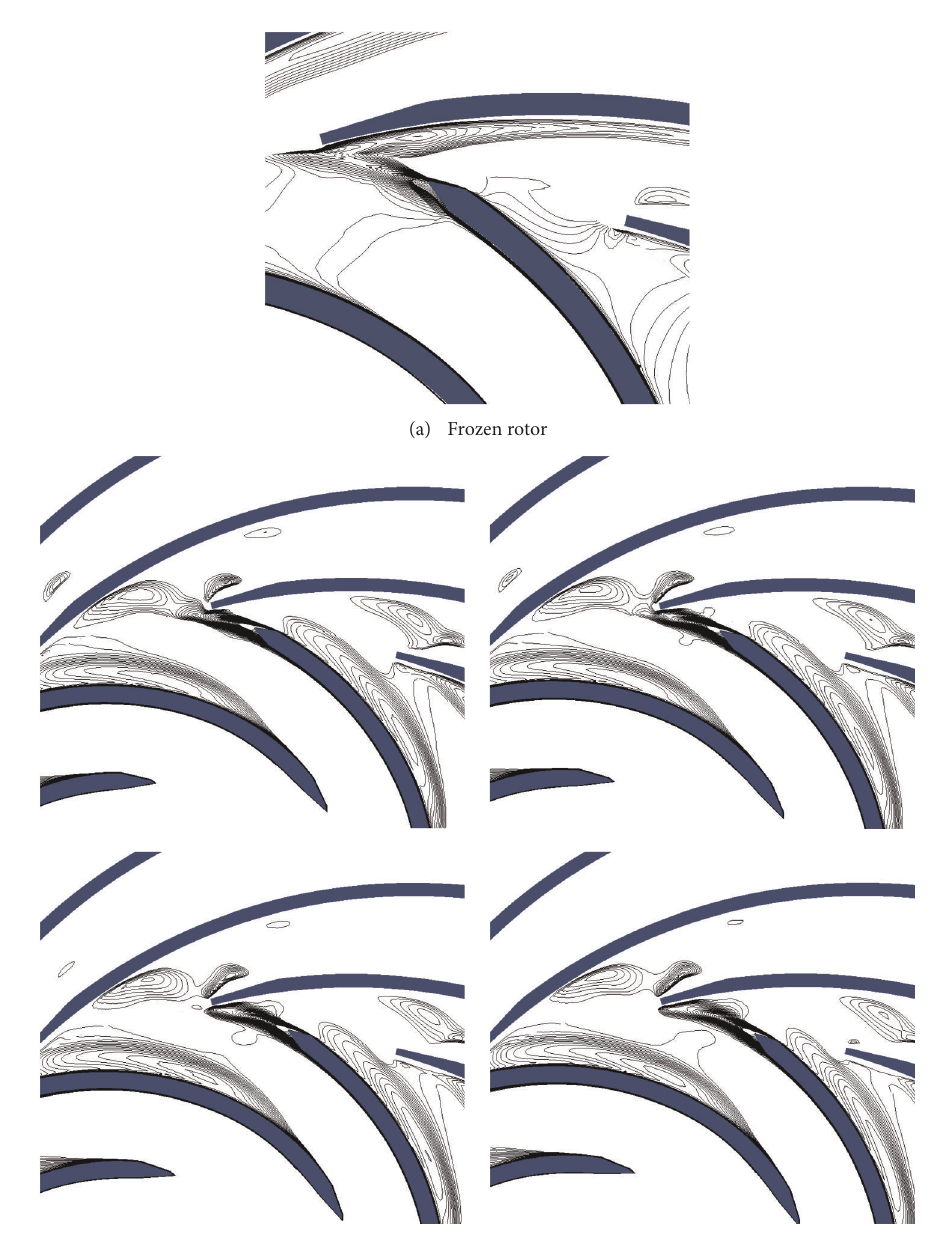
Figure 12: Prediction of the wake behind the impeller for the frozen rotor and sliding grid